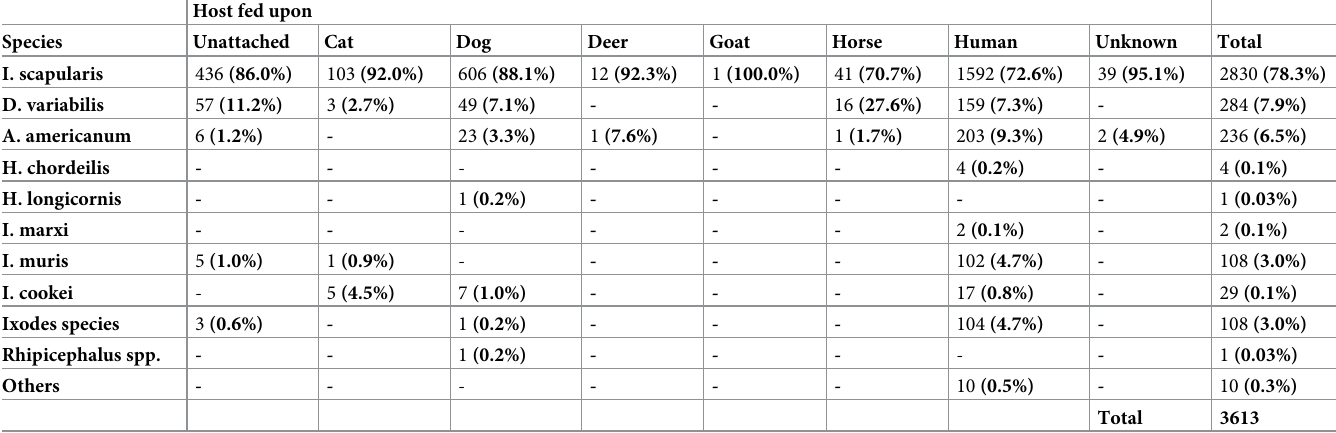
Table 2. Animal origins of submitted ticks. The majority of ticks submitted originated from humans and closely associated animals (pets), with small numbers submit- ted from horses, deer, and a goat. Some detected ticks were unattached, although most were found on a mammalian host. The percentages of each tick species acquired from a specific host are listed beside the numbers of ticks submitted in each